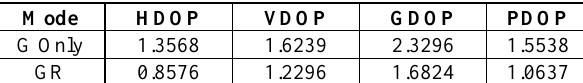
Table 1: Average DOP values